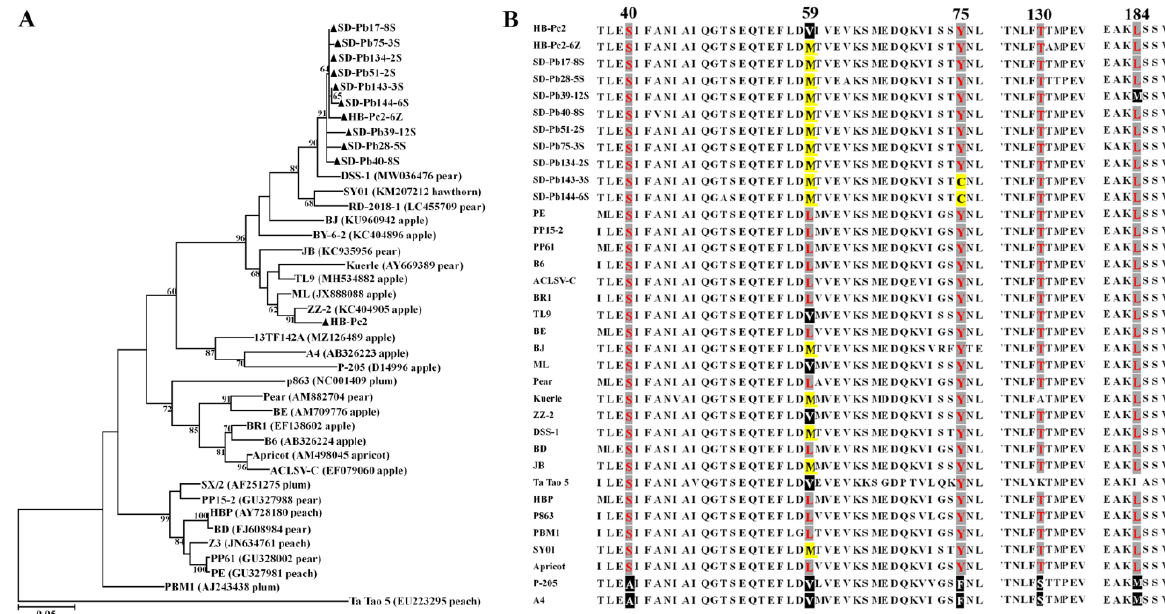
Figure 3. Unrooted maximum-likelihood (ML) phylogenetic tree generated from the nucleotide sequences of CP gene ( A ) and multiple amino acid sequence alignment of CP ( B ) of apple chlorotic leaf spot virus (ACLSV). ( A ) Each of reported sequences in the tree was marked by its isolate name followed by a GenBank accession number and host name, the sequences determined in this study were highlighted by black triangles and marked by its geographic origin, host and clone ID, and sequences from seedlings and seeds were identified with ‘S’ and ‘Z’. The corresponding sequence of an isolate Ta tao 5 was used as a outgroup in the phylogenetic tree. ( B ) The amino acids at five positions 40, 59, 75, 130, and 184 for the discrimination of B6 and P-205 types were shaded with gray and black background colors, respectively, and yellow background color showed amino acids different from B6 type.